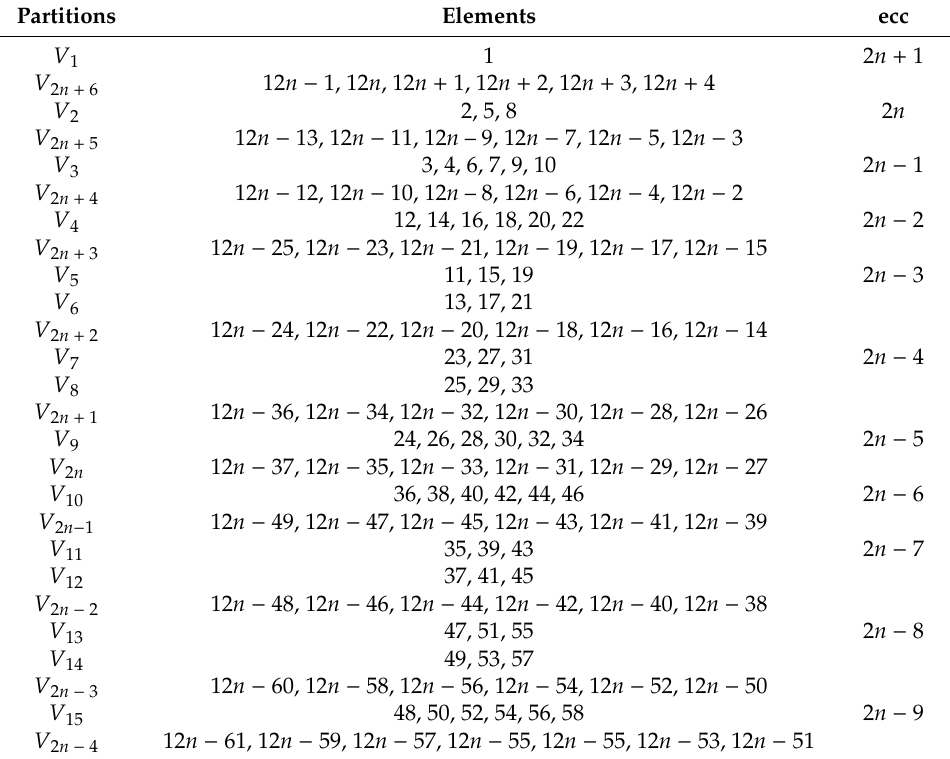
Figure 17. The Hosoya-partitions of Tz [6, n − 10]. Table 5. The H -partition and eccentricity of fullerene graph.